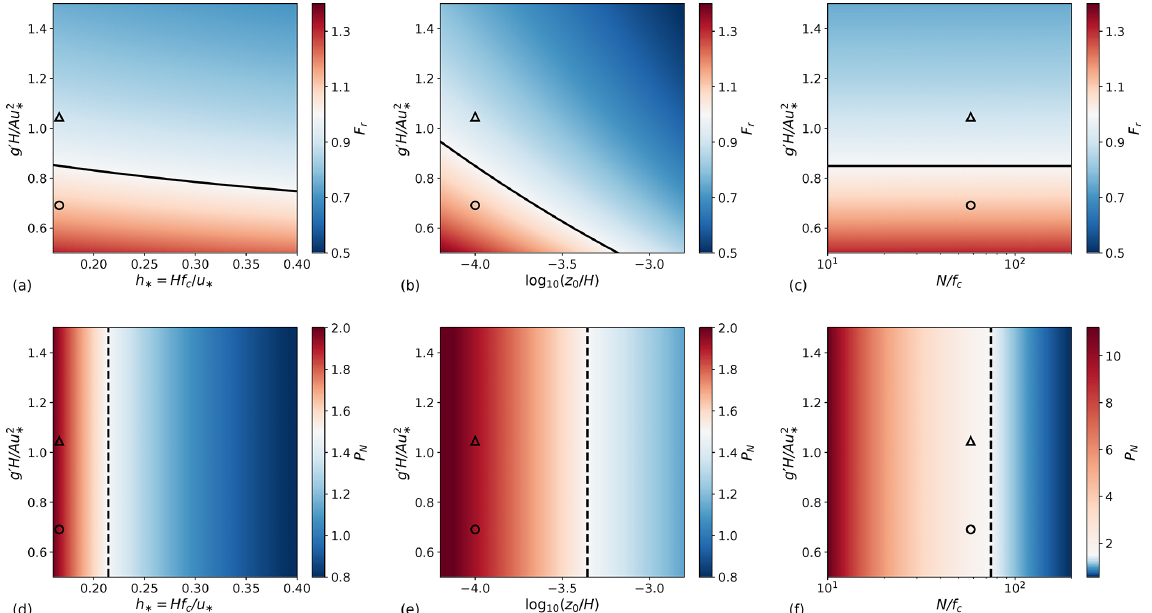
(cid:112) g (cid:48) H and (d–f) P N = U 2 /NH (cid:107) U g (cid:107) to atmospheric conditions. (a, d) Non- Figure 6. Sensitivity of (a–c) Froude number Fr = U B / B dimensional boundary layer height h ∗ (with z 0 = 10 − 4 and N/f c = 58), (b, d) logarithm of the non-dimensional surface roughness length z 0 (with h ∗ = 0 . 166 and N/f c = 58) and (c, f) ratio of Brunt–Väisälä frequency to Coriolis parameter N/f c (with h ∗ = 0 . 166 and z 0 = 10 − 4 ) against the inversion parameter g (cid:48) H/Au 2 ∗ . The black solid lines in (a–c) correspond to critical flow conditions ( Fr = 1) while the dashed black ones in (d–f) correspond to flow conditions of P N = 1 . 5. The markers (cid:52) and ◦ represent the sub- and supercritical flow cases studied in Section 4.1, respectively. Note that (f) uses a different scale than (d, e)